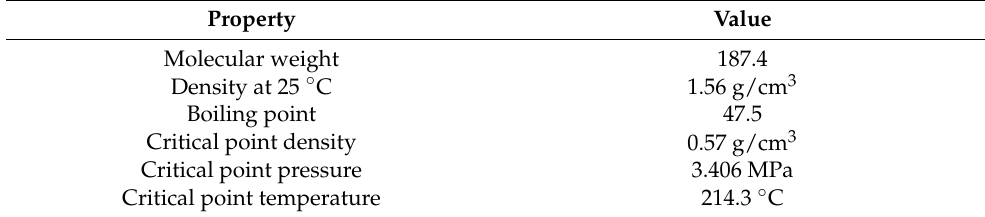
Table 1. Physical and thermal properties of the